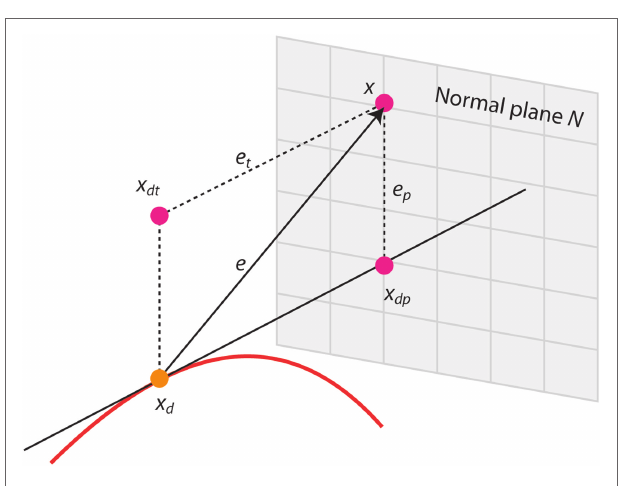
FIGURE 3 | The tangential error ( e t ) is the projection of the error ( e ) between the actual ( x ) and desired position ( x d ) on the trajectory tangent through the desired position . The perpendicular error ( e p ) is the projection of the error ( e ) on the plane defined by the tangent and actual position ( N ).